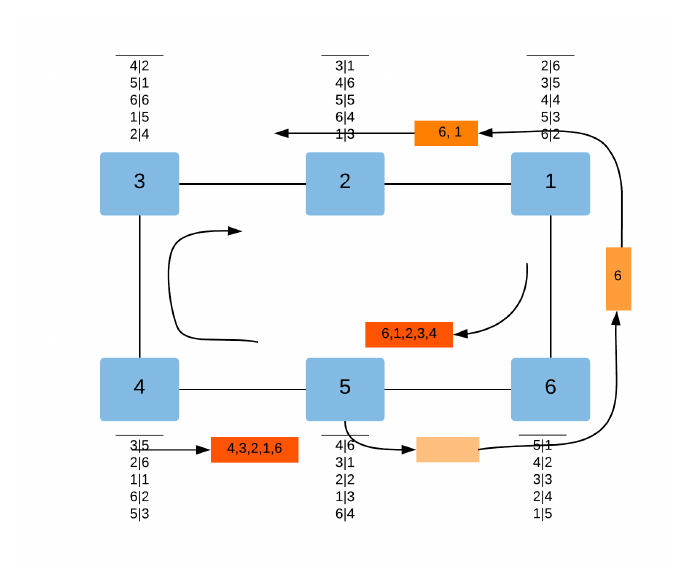
Figure 10. The QoS-ARRP Auto-configuration Mechanism after a failure